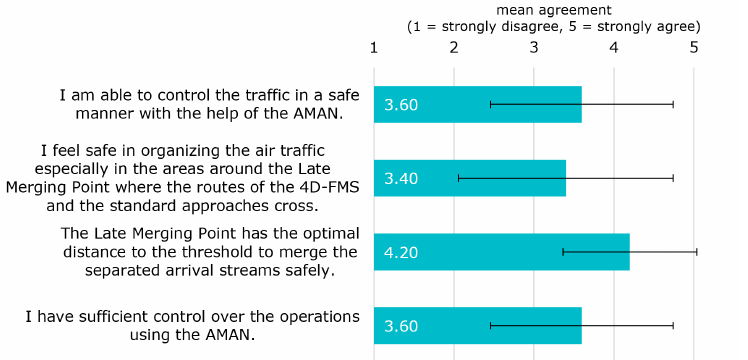
Figure 13. Mean agreement to tailored statements regarding the perceived safety for all scenarios. Error bars represent standard